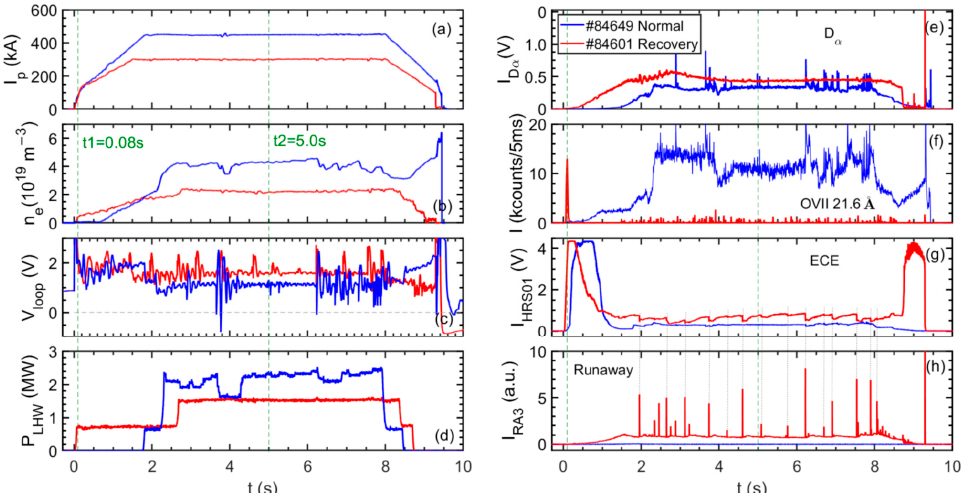
Figure 3. Time-evolution of ( a ) plasma current, I p , ( b ) line averaged electron density, n e , ( c ) loop voltage, V loop , ( d ) total injection power of low hybrid wave (LHW), ( e ) line intensity of D α , ( f ) line intensity of O VII (O 6+ ) at 21.6 Å, ( g ) intensity of electron cyclotron emission (ECE) of HRS01, ( h ) runaway electron flux signal in recovery discharge #84601 (red lines) and normal discharge #84649 (blue lines). Vertical gray lines in ( g , h ) indicate the timings of corresponding jumps and spikes in ECE and Runaway signal, respectively.